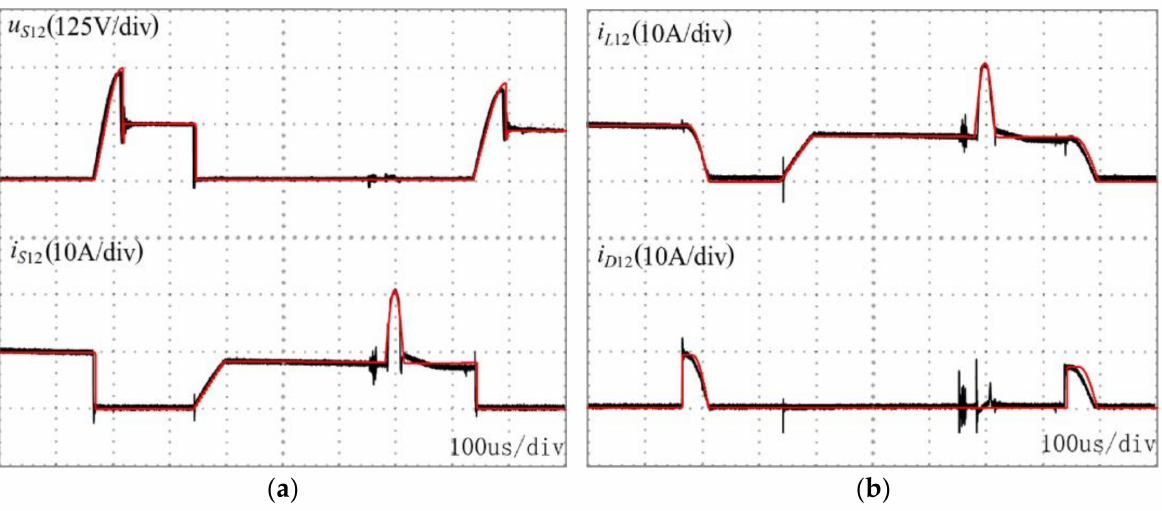
Figure 13. Comparison of measured (black lines) and calculated (red lines) waveforms of ( a ) main switch S12, and ( b ) inductor L12 and diode D12,